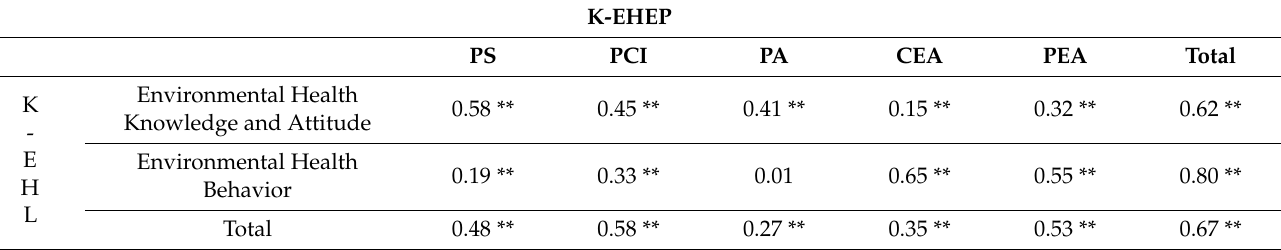
Environmental Health Knowledge and Attitude